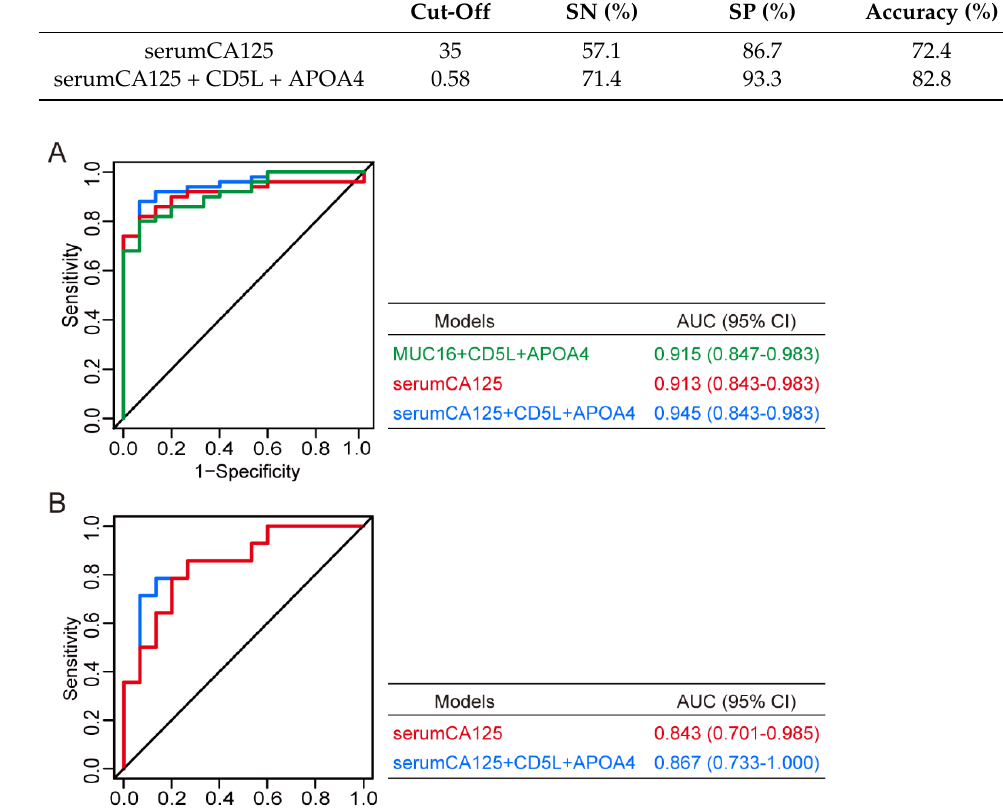
Table 8. The evaluation indicators of the differential models in patients with ovarian masses.